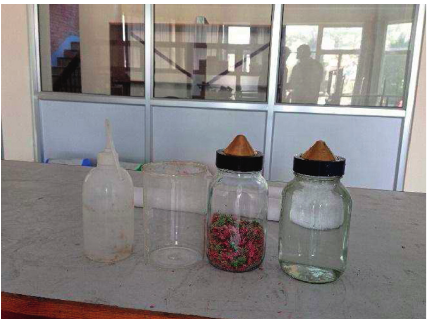
Figure 3: Specific gravity